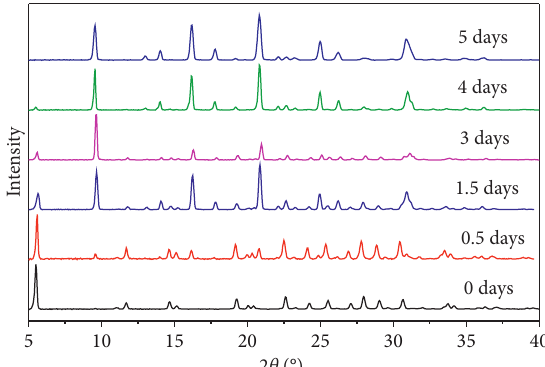
Figure 5: X-ray diffraction patterns of as-made zeolite products (0 to 5 days) prepared using LTL as Al source and DMACHA as the OSDA. Table 2: Synthesis parameters of high-silica CHA zeolites by interzeolite transformation and some product properties. Sample no.